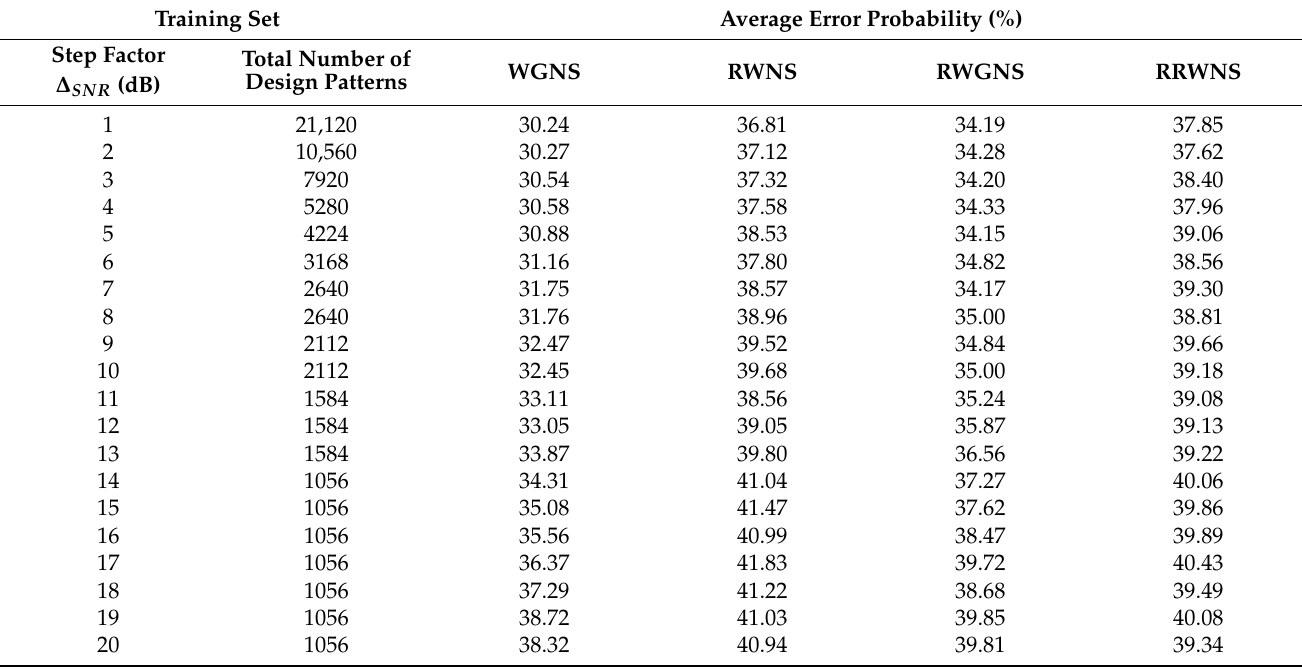
Figure 6. Second stage experiment results: test sets error probabilities for three different models (Reverberated Real-World Noise Scenario). Table 4. Second stage experiment results. Average error probability